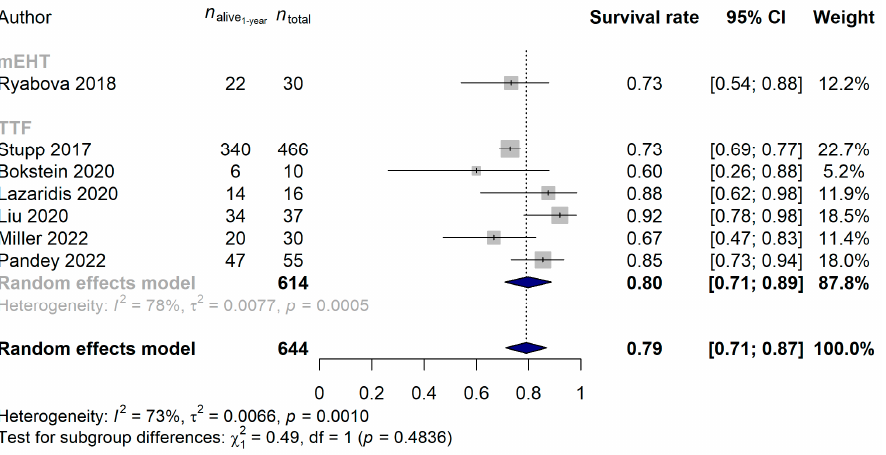
Figure 10. In recurrent glioblastoma, the non-inferiority ( p = 0.8618) of modulated elec- tro-hyperthermia (mEHT) could be observed compared with the more widely applied Tumor Treating Fields (TTF). It has to be noted that due to the wider acceptance of the Stupp protocol [10,71] and that patient survival significantly improved in the last decade [72], only the comparison of studies conducted after 2010 were compared [21,51,53,57,66,68,69].